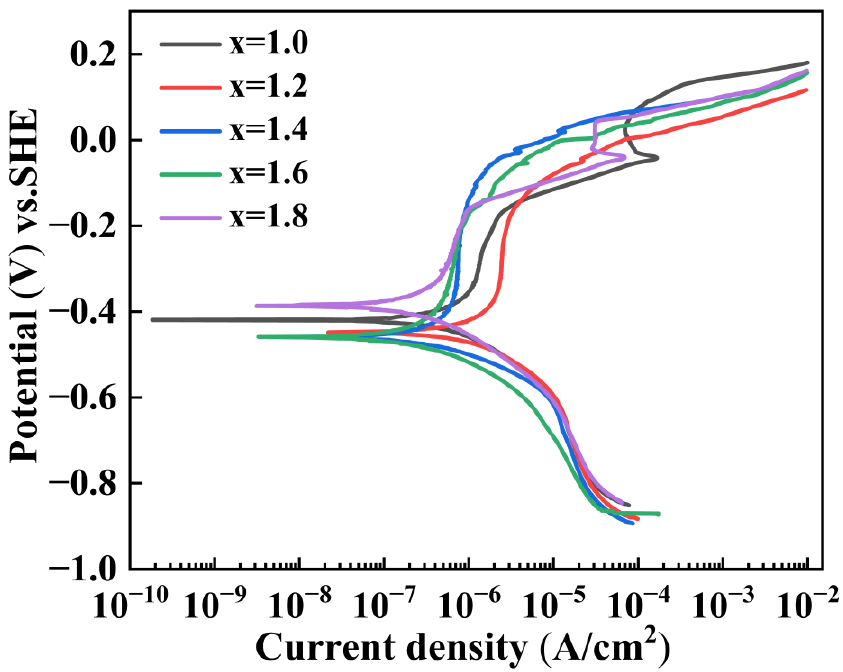
Figure 6. Potentiodynamic polarization curves of AlSi 0.5 Cr x Co 0.2 Ni (x = 1.0, 1.2, 1.4, 1.6, and 1.8) high entropy alloys.